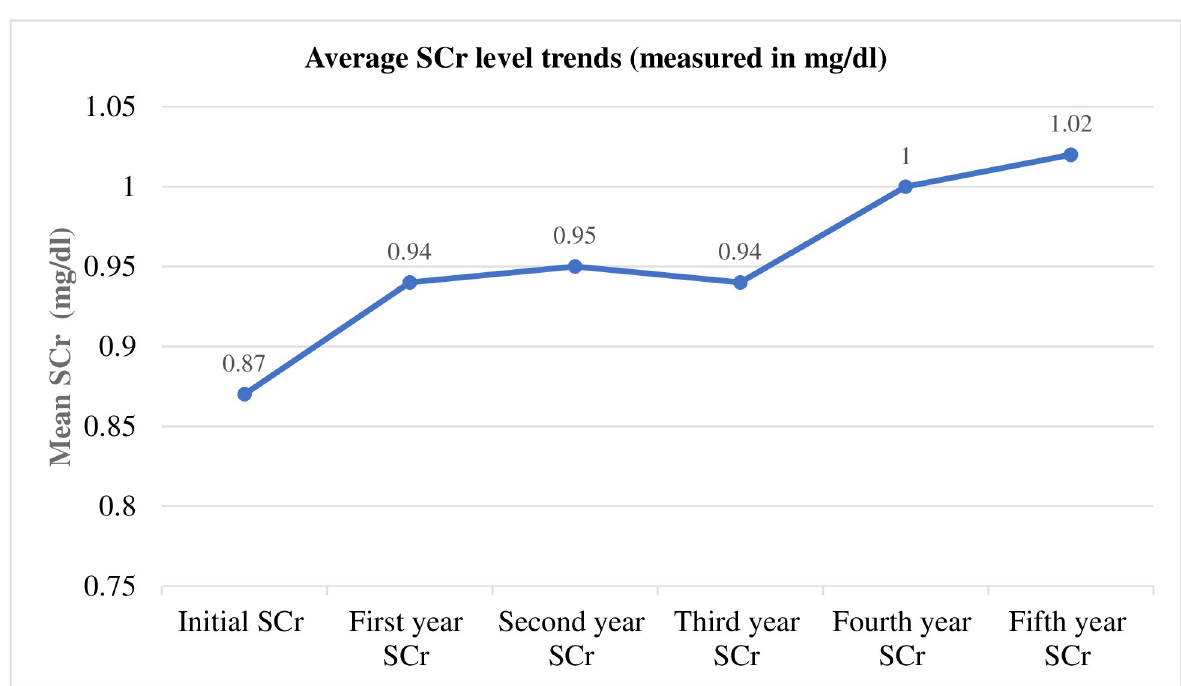
Fig 1. The mean serum creatinine measurement trends (mg/dl) across different months of the follow-up in patients with diabetes mellitus.